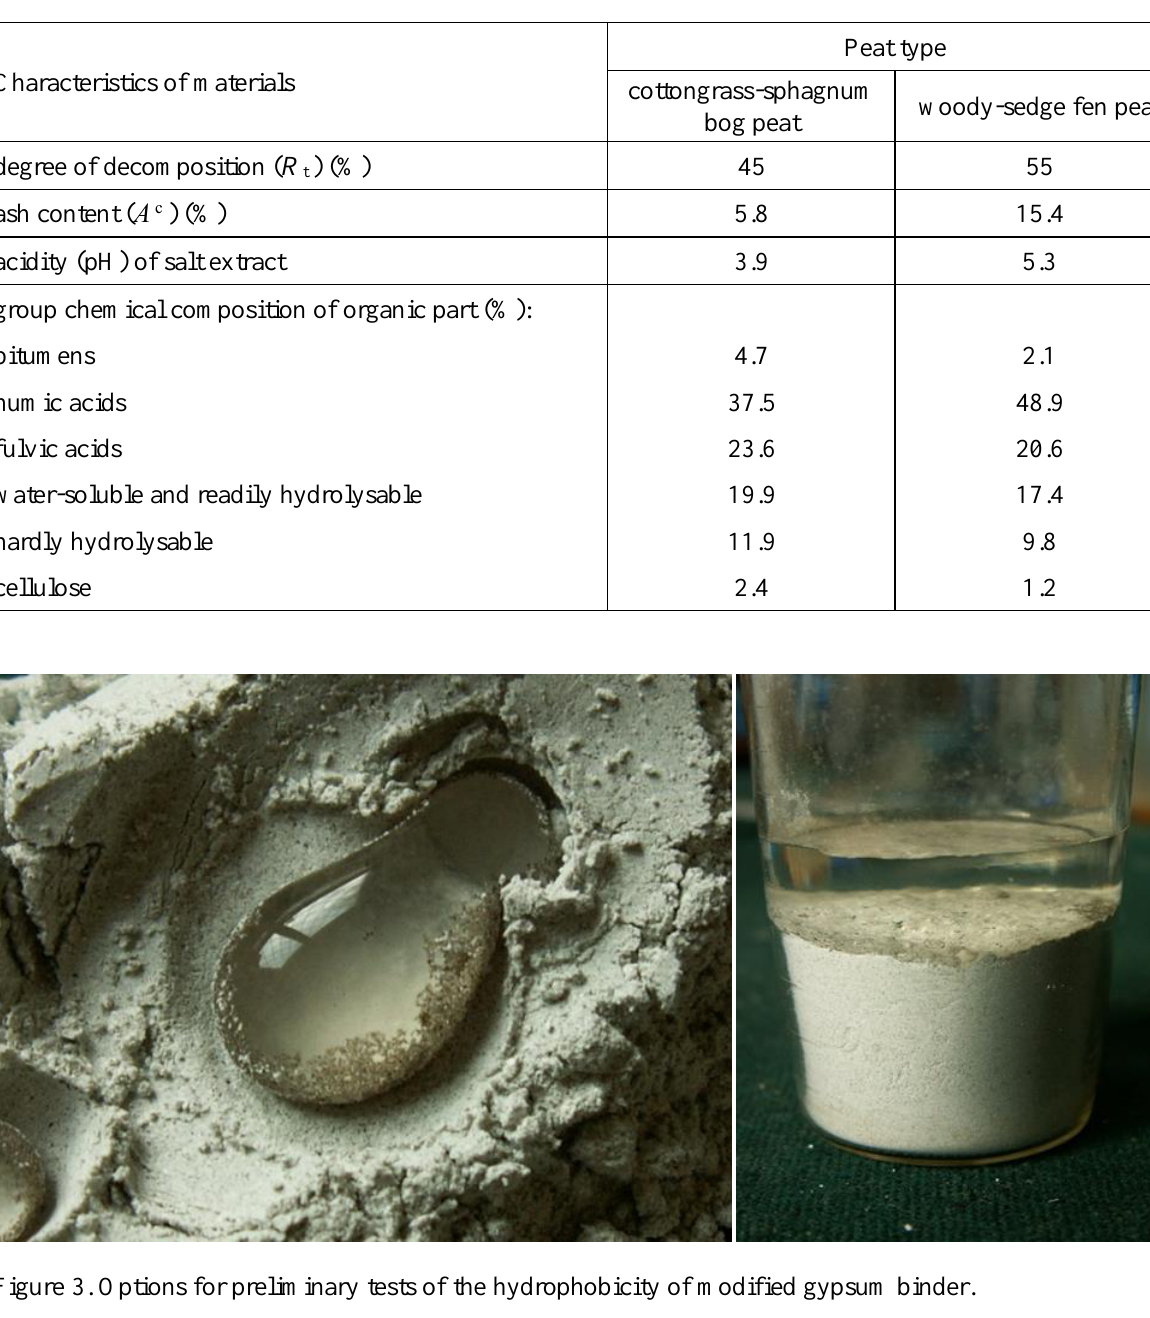
Table 3. Characteristics of the peat raw materials used.